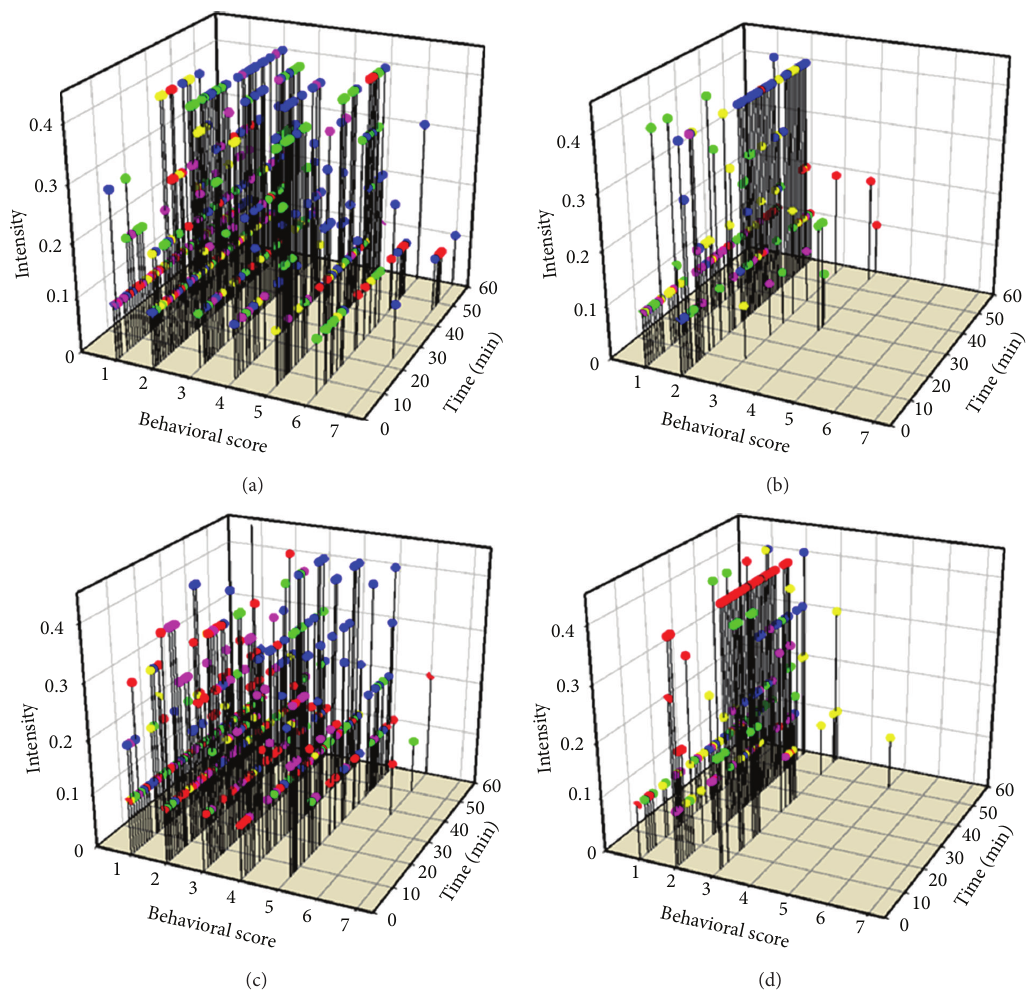
Figure 7: Comprehensive representation of social interactions for cave crayfish in varying environmental conditions (a) Red light and in water. (b) Red light and out of water. (c) Red light, no antennules and, in water. (d) Red light, no antennules and, out of water. A single vertical line indicates a given behavior at a specific point in time as well as the intensity of the behavior. The different colored points represent a total of each individual pairs of crayfish in the trials (𝑁 = 5)